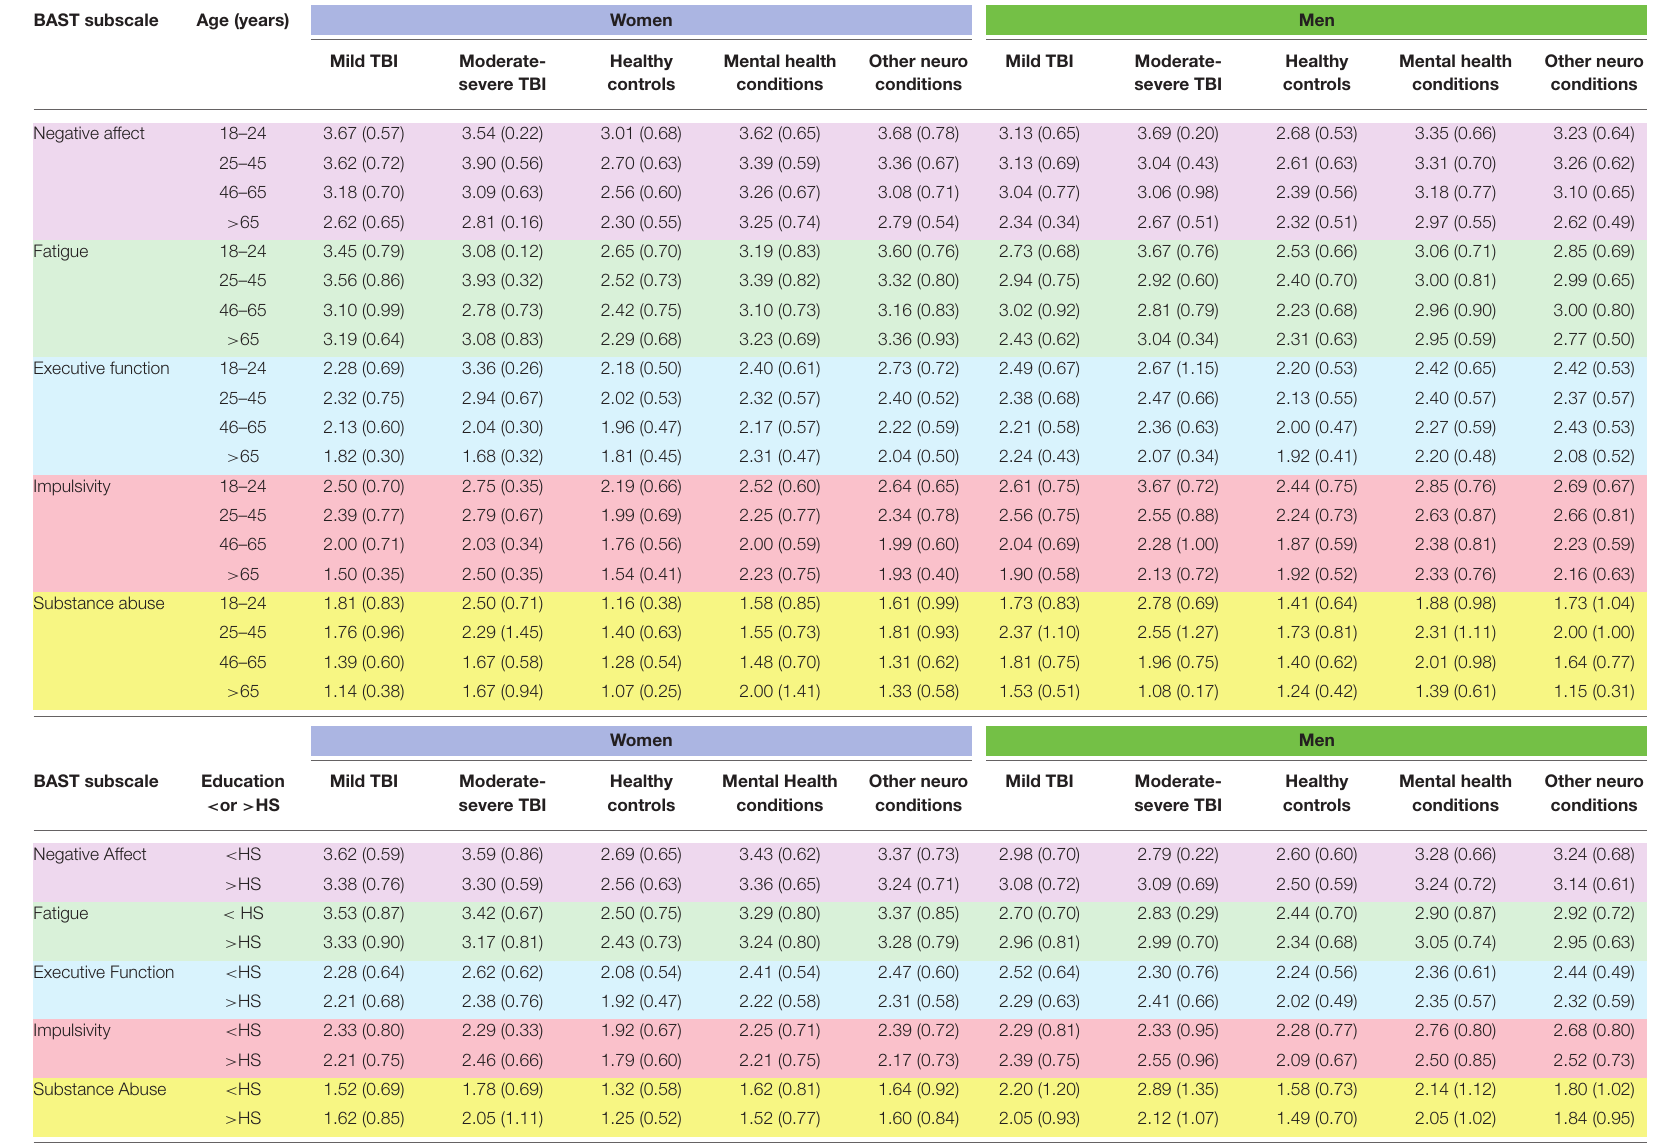
TABLE 2 | Neurobehavioral symptoms by gender, neurological and mental health conditions, age, and education among English-speakers. BAST